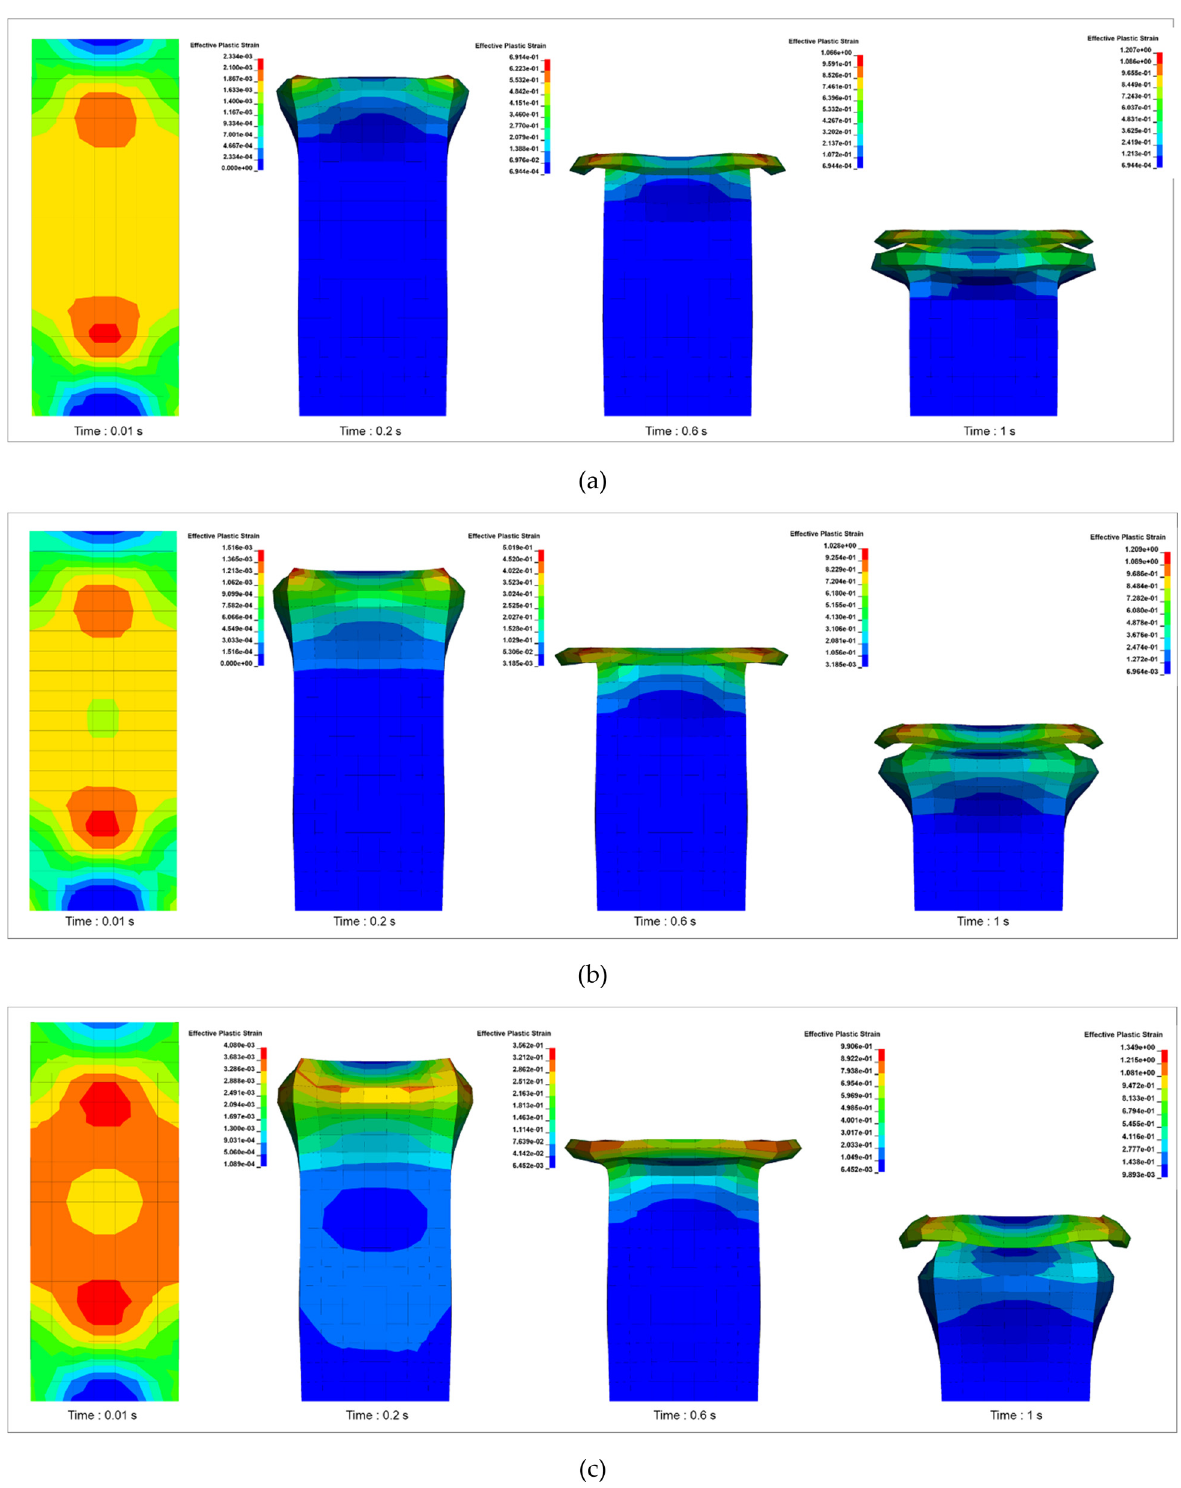
Figure 15: Distribution of the strain on the specimen scaling the time from 0.01 to 1 s. ( a ) 2 mm wall thickness, ( b ) 3 mm wall thickness, and ( c ) 4 mm wall